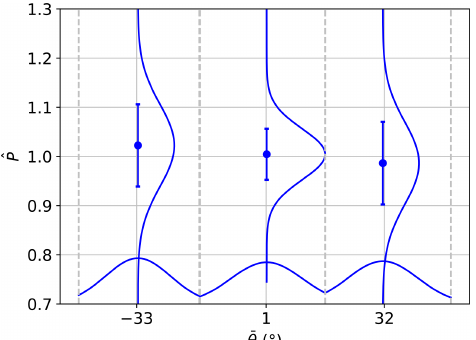
Figure 10. Power output normalised by the power derived from the power curve for different wind directions. Dots and error bars represent means and standard deviations within each bin, while the continuous lines represent the distributions of ˆ P and θ within each